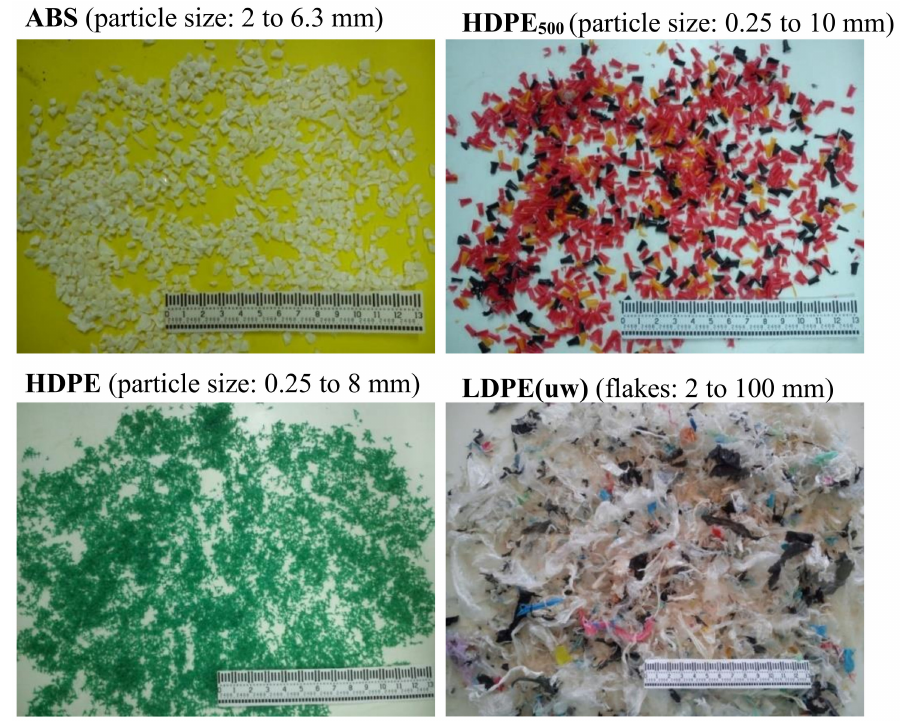
Figure 2. Types of plastic waste used as polymers in the studied asphalt mixtures in the present